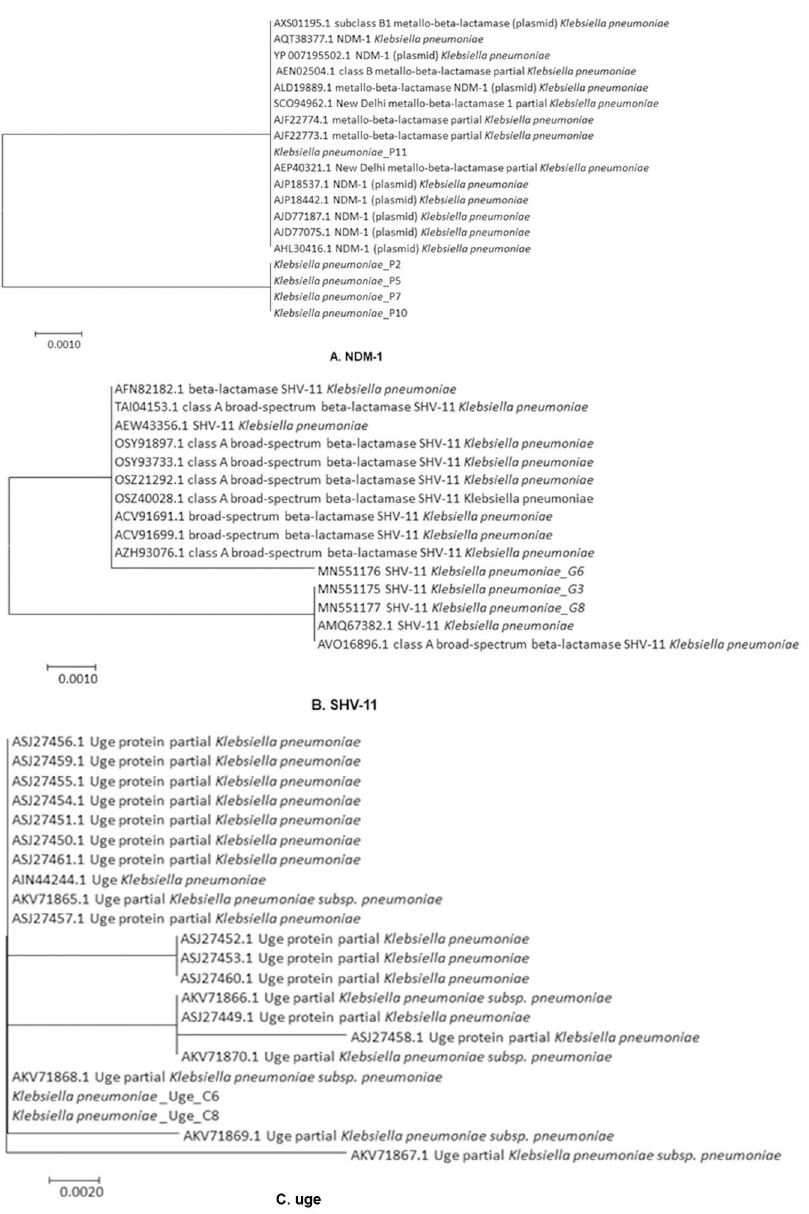
Fig 4. Phylogenetic analyses of NDM-1 , SHV-11 and Uge genes from multidrug-resistant KPN isolates by maximum likelihood method. The evolutionary history was inferred by using the Maximum Likelihood method based on the JTT matrix-based model. Three genes are A) NDM-1, B) SHV-11, C) uge.